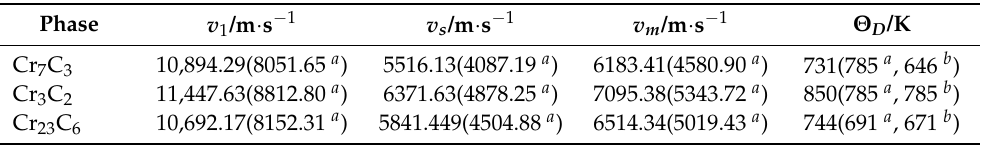
Table 6. Theoretically calculated thermal properties of chromium carbides, including v 1